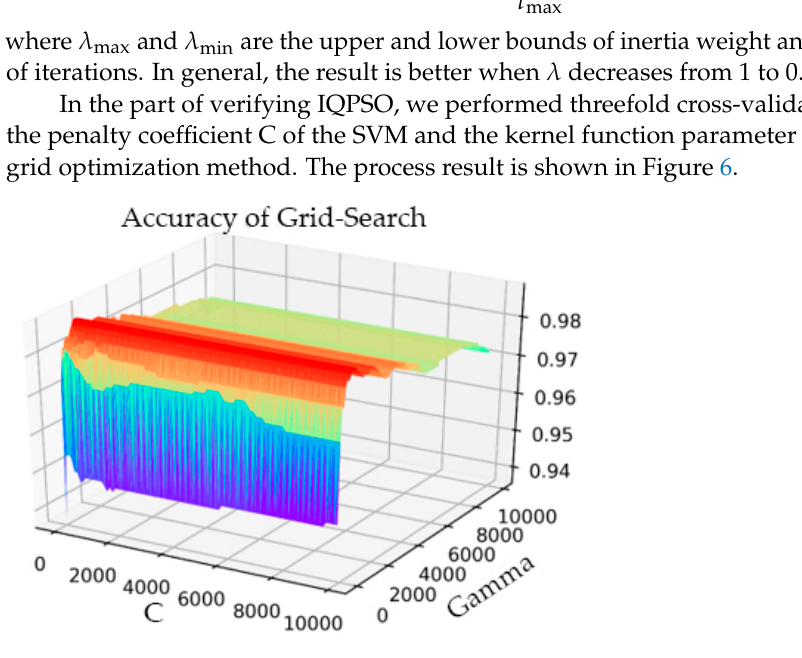
Figure 7. Relationship between the number of iterations and accuracy of IQPSO-SVM. Experiments were conducted for the cross-validation of different fold numbers, 3- fold, 5-fold, and 10-fold cross-validation, and comparison of the performance of Grid Search and IQPSO-SVM. The detailed classification accuracy and model tuning time-con- suming experimental results are listed in Table 4. The results are represented by the aver- age and deviation. In the case of cross-validation with different fold numbers, the IQPSO